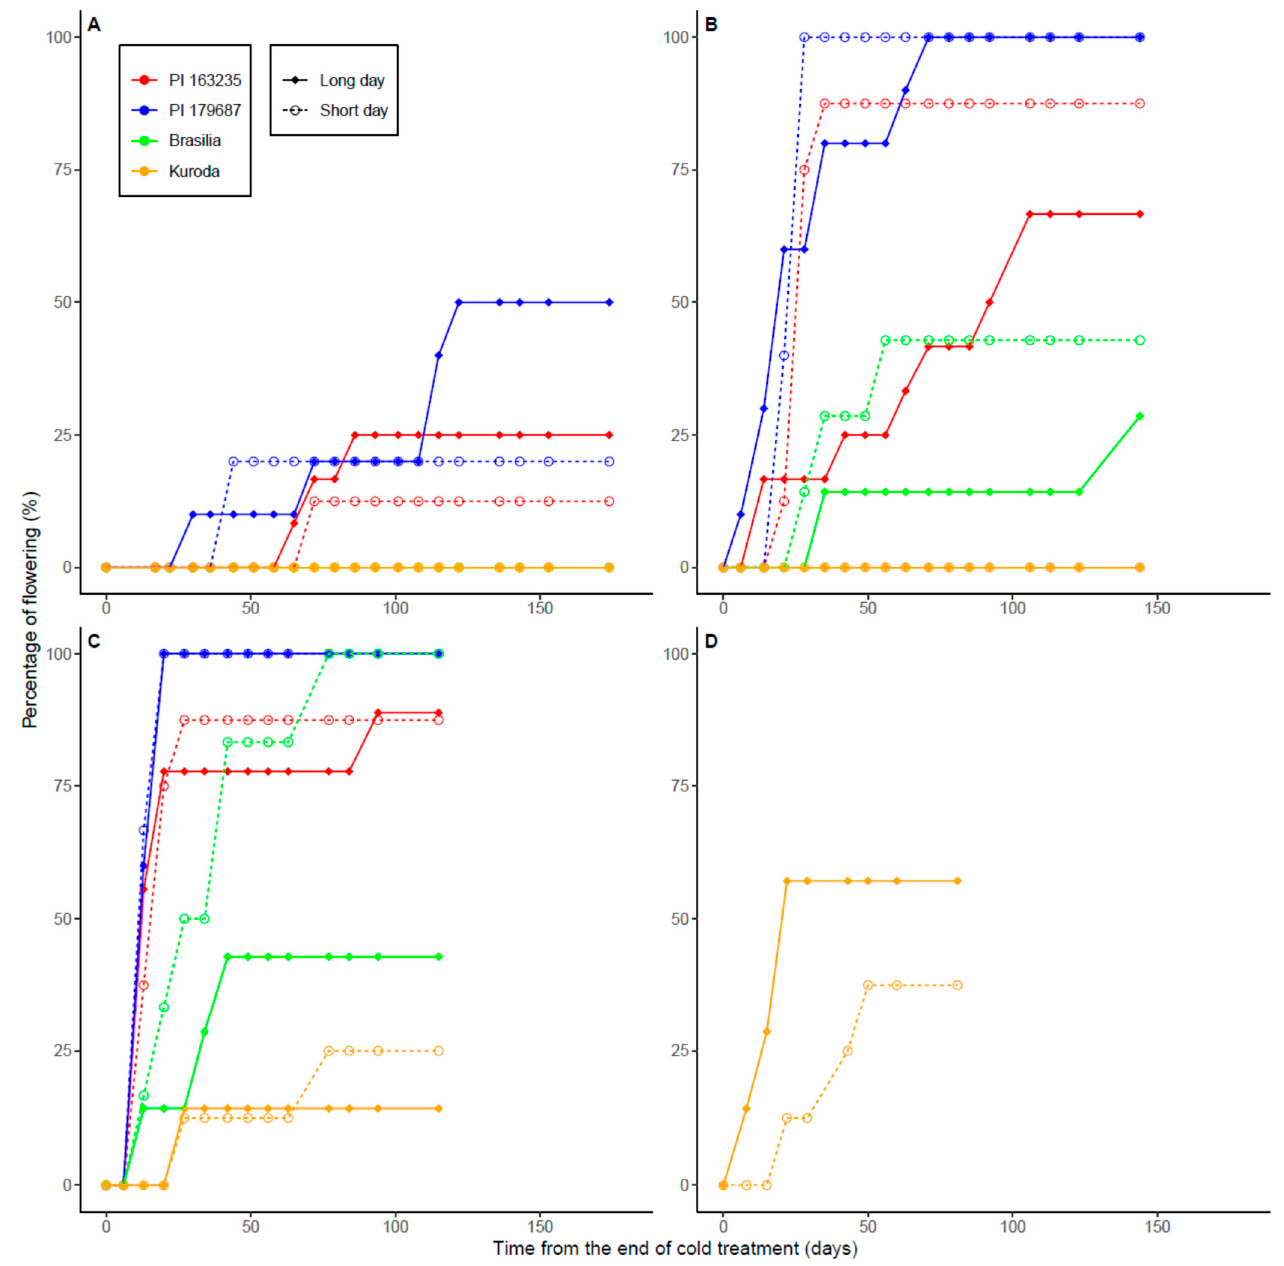
Figure 1. Percentage of flowering in the annual carrot accessions PI179687 and PI163235, the annual cultivar Brasilia, and the biennial cultivar Kuroda after 30 ( A ), 60 ( B ), 90 ( C ), and 120 ( D ) days of cold exposure (mean daily temperature was 7.53 °C). No flowering was observed in control treatment plants grown at ~23 °C and LD (data not shown).